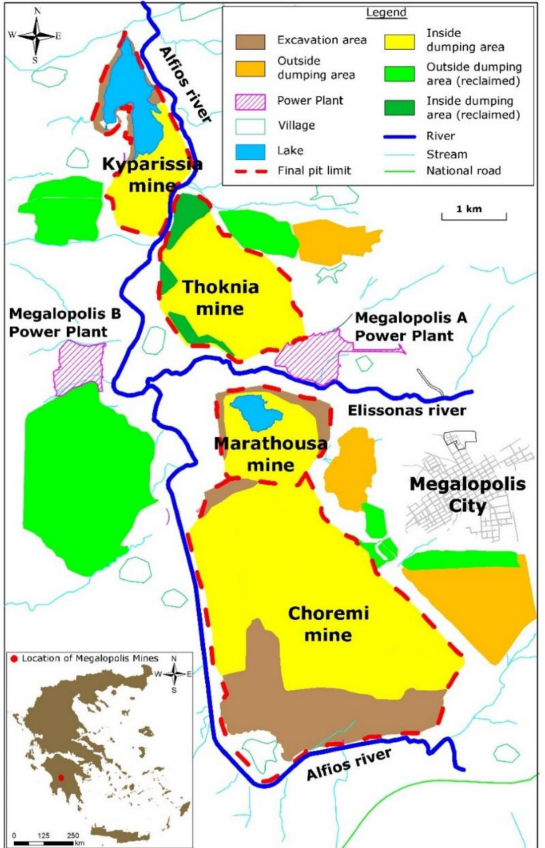
Figure 2. Overview of the Megalopolis mines entering the closing phase (case